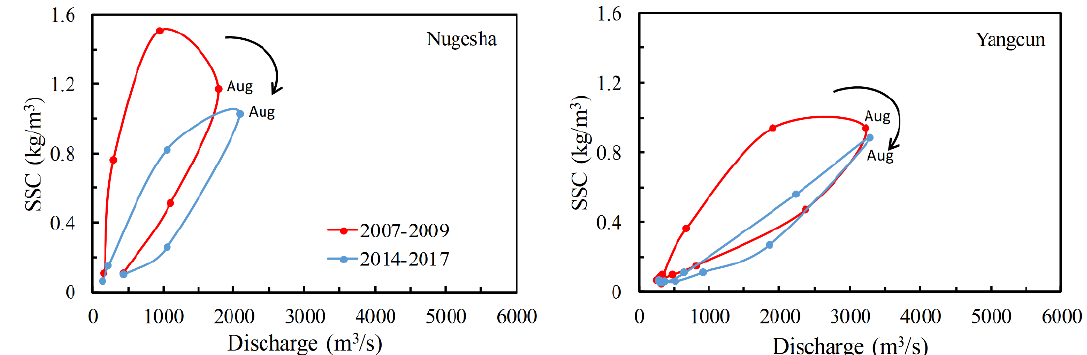
Figure 5. Q-SSC hysteresis at the Nugesha and Yangcun Stations.